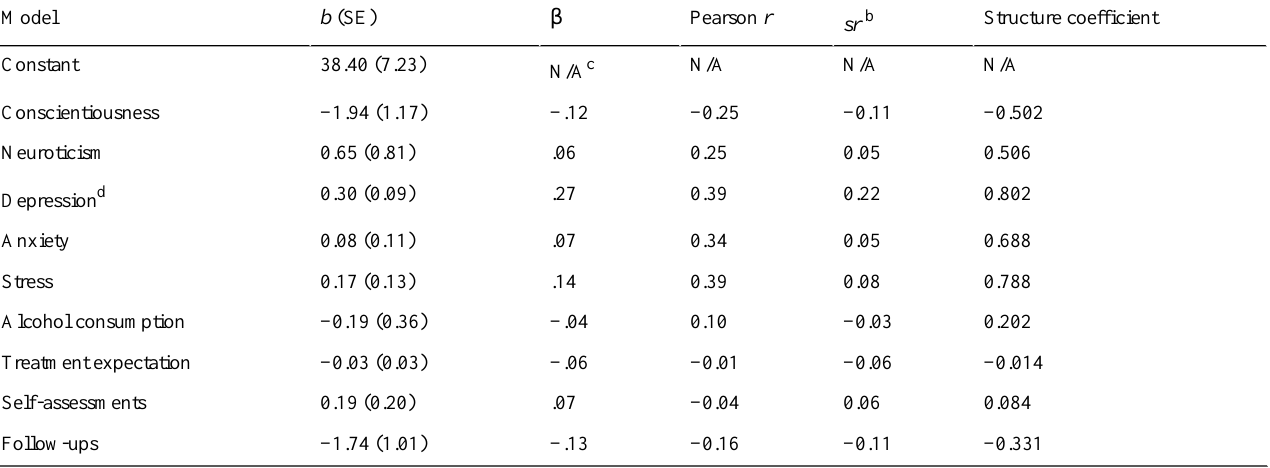
Table 6. Standard regression results for personality, negative affect, treatment expectations, and study engagement predicting quality of life (n=191) a